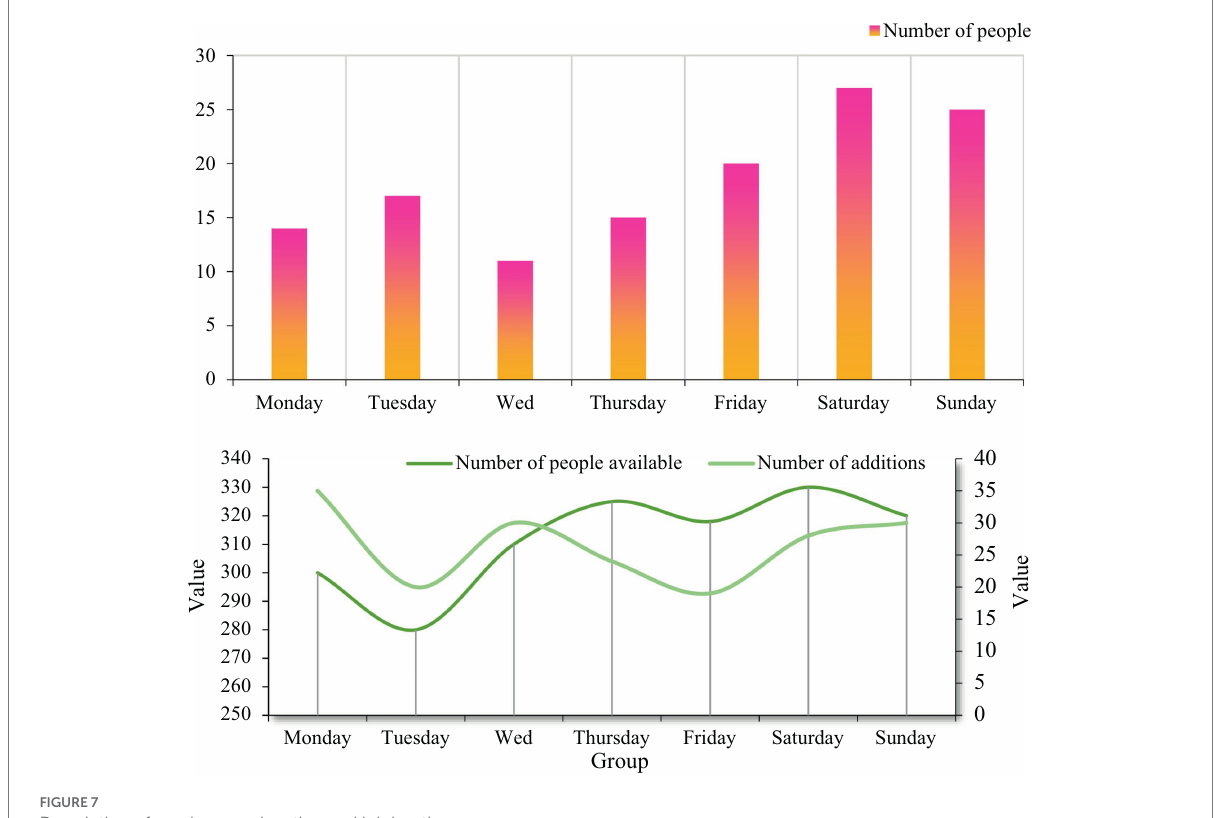
FIGURE 7 Description of employee resignation and job hunting.